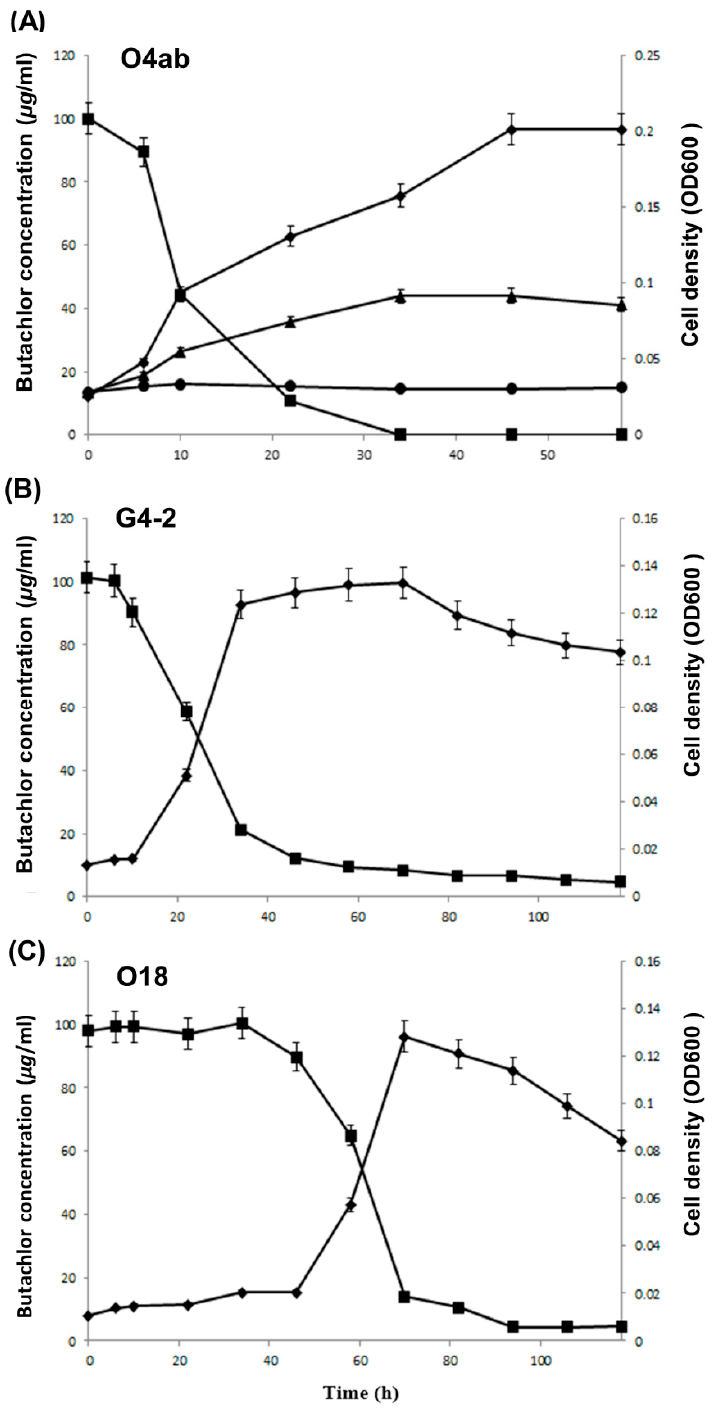
Figure 2. Utilization and degradation of butachlor by the isolates. ( A ) Butachlor degradation and cell growth of syntrophic pair O4ab. (cid:4) : residual concentration of butachlor; (cid:7) : OD 600 of O4ab pair in butachlor mineral medium; (cid:78) : slight growth of O4a; • , no growth of O4b. ( B ) Butachlor degradation and cell growth of G4-2. (cid:4) : residual concentration of butachlor; (cid:7) : OD 600 of G4-2 in butachlor mineral medium. ( C ) Butachlor degradation and cell growth of O18. (cid:4) : residual concentration of butachlor; (cid:7) : OD 600 of O18 in butachlor mineral